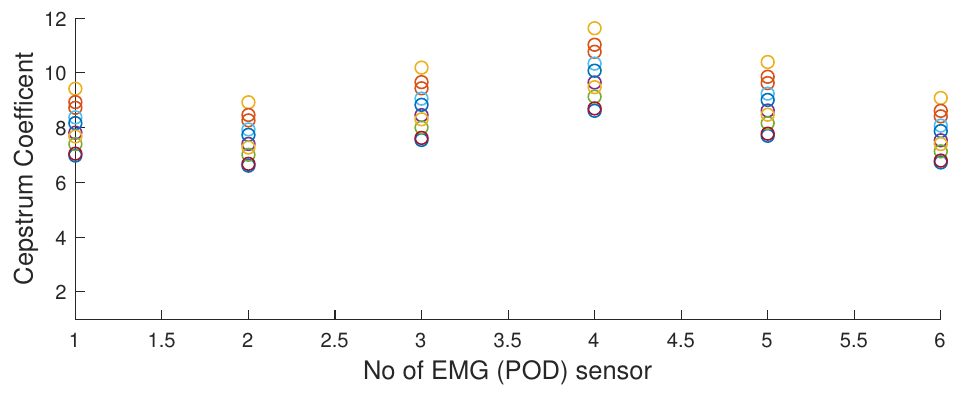
Figure 12. Cepstrum analysis of EMG six sensors. Table 4. Classification of different SVM kernel functions.